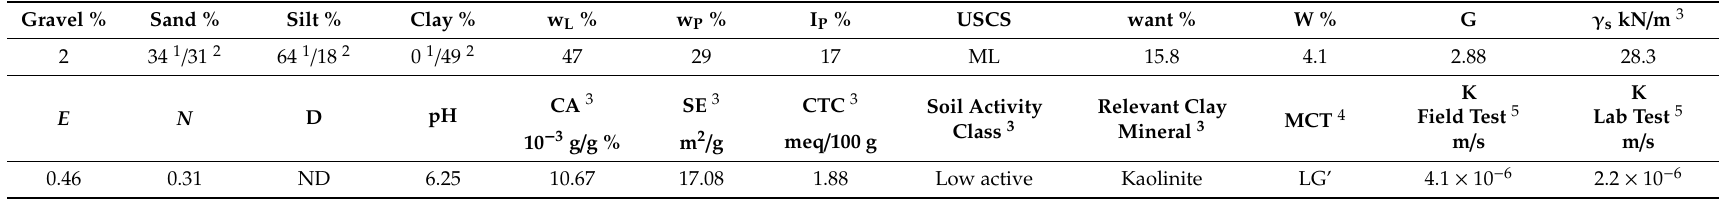
Table 1. Geotechnical properties of lateritic soil.